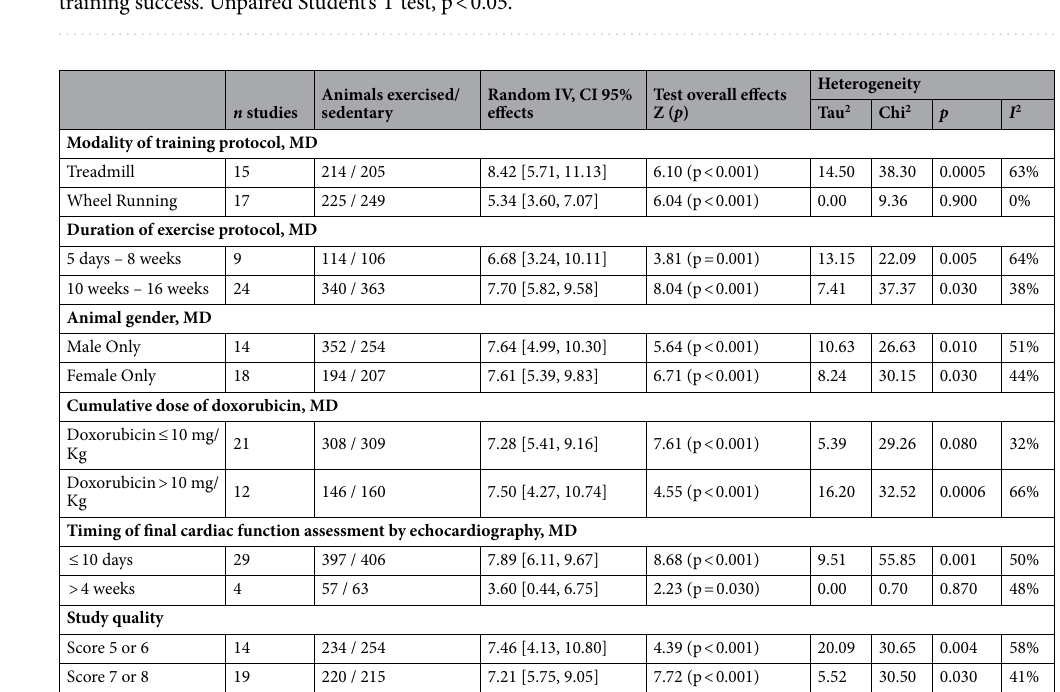
Random IV, CI 95%